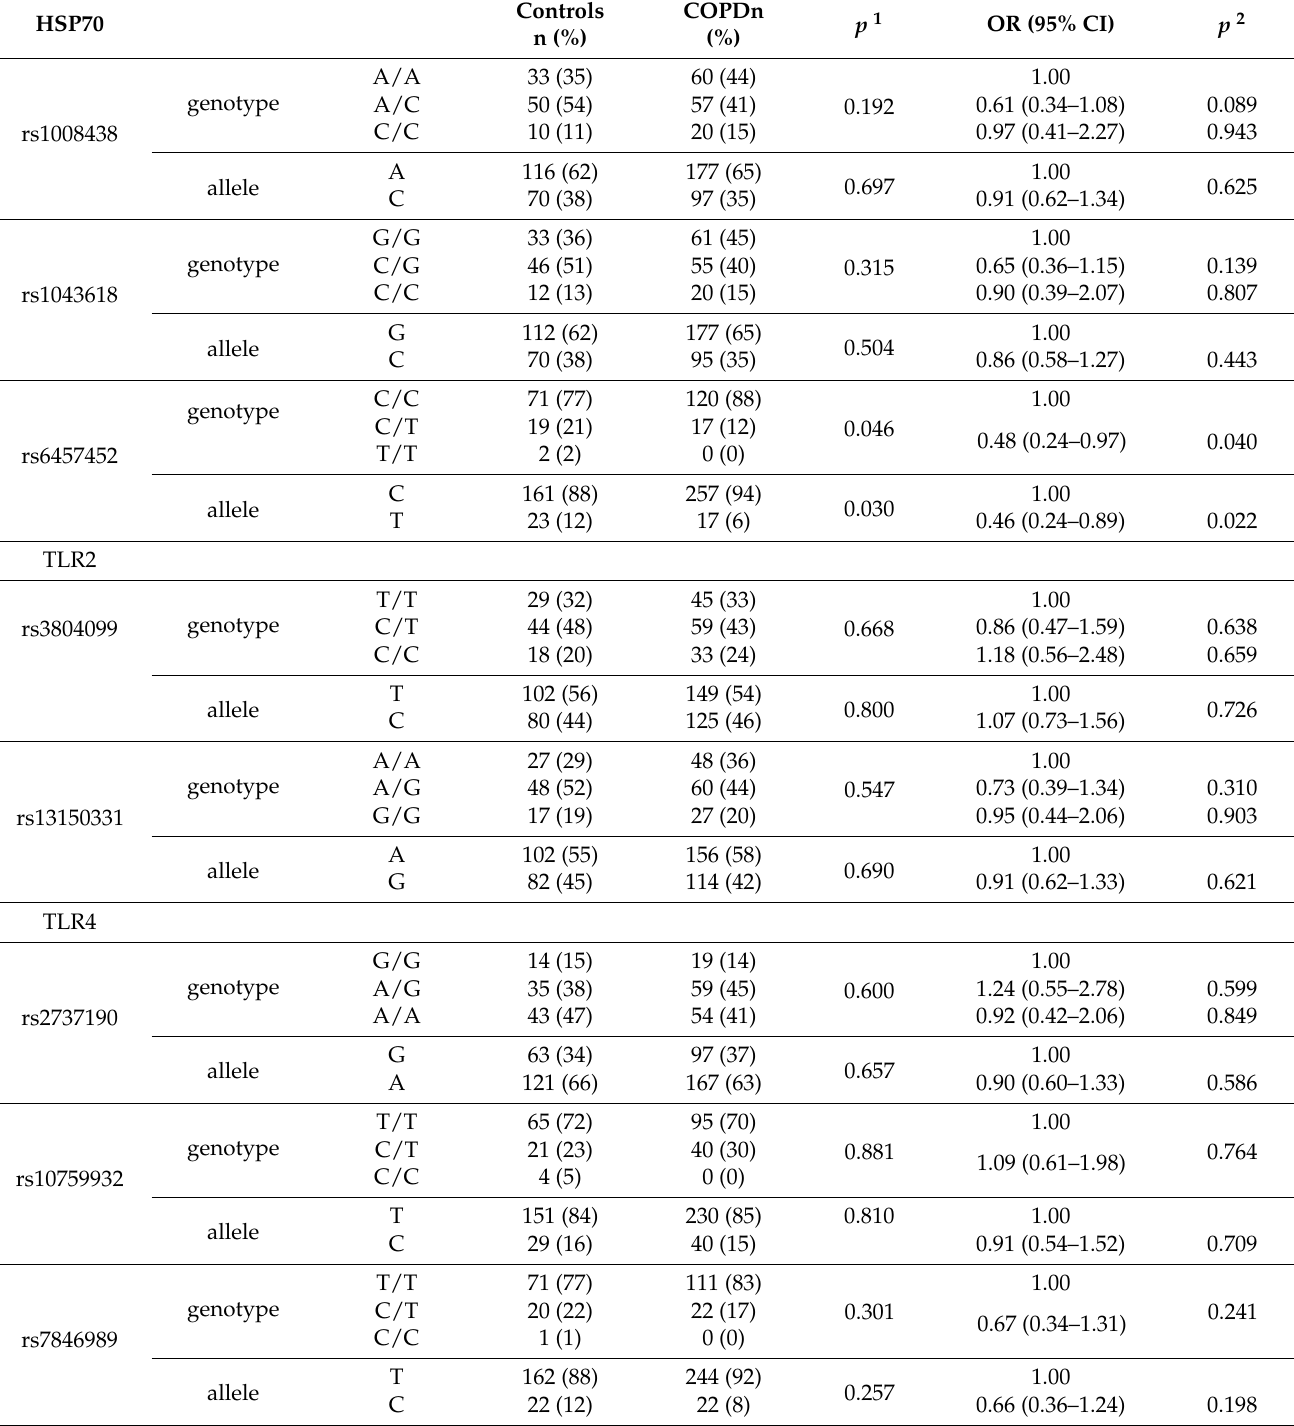
Table 6. Genotype and allele distribution of HSP70 , TLR2 and TLR4 polymorphisms in controls and COPD patients, and association analysis between investigated polymorphisms and COPD risk.